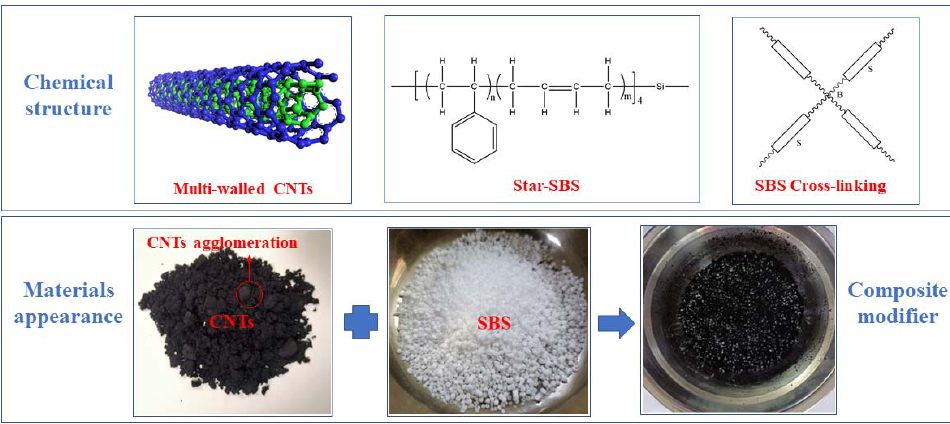
Figure 1. Schematic diagram of CNTs/SBS composite modifiers.